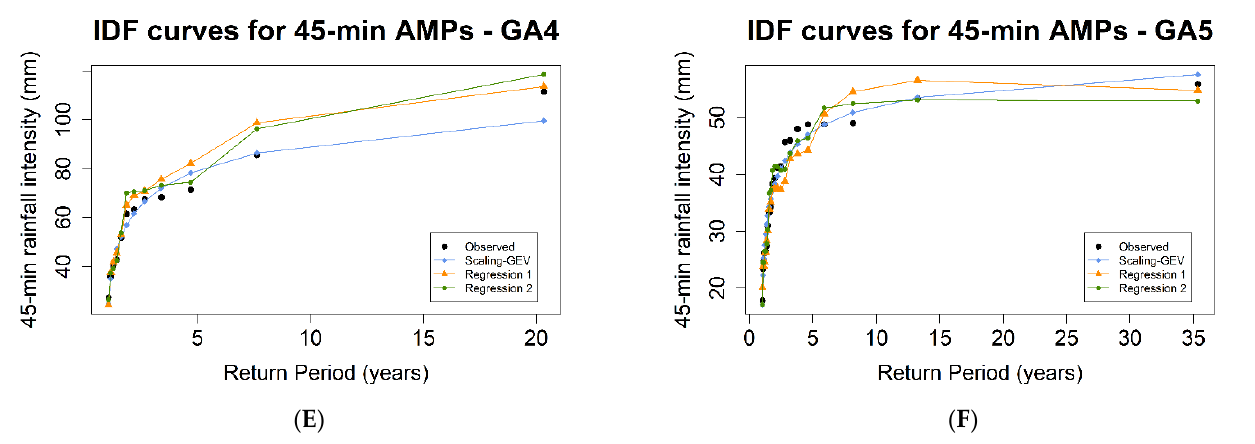
Figure 6. IDF curves for comparing the estimation method of sub-hourly frequencies. Two stations (Mt Chachao and Mt Santo Rosa) are selected. Breakpoints are clearly observed at Mt Chachao (GA4) but not clear at Mt. Santa Rosa (GA5). ( A , C , E ) are IDF curves for the 15-min, 30-min, and 45-min durations for Mt. Chachao station, and ( B , D , F ) are those for Mt. Santa Rosa, respectively. To identify the regional heavy rainfall characteristics, the inverse-distance weight (IDW) method as a geospatial interpolation is applied to the estimated scaling exponents with coordinates of rain gages for regional analyses. Figure 7 shows regional scaling exponent maps for the short duration (A) and the long duration (B), respectively. Again, the northern portion of Guam is a broad uneven limestone plateau, while the southern portion is a volcanic upland. The orographic features, which are characterized by Mount Alutom and Mount Lam Lam, located in Southern Guam, induce a more intense rainfall amount with a short duration as shown in Figure 6A. On the contrary, the northern portion receives more rainfall for a longer duration from 45 min to 24 h. It implies that the southern portion, having the high values of slopes, is more likely to be vulnerable to flash floods induced by intensive storm rainfall within a very short duration.